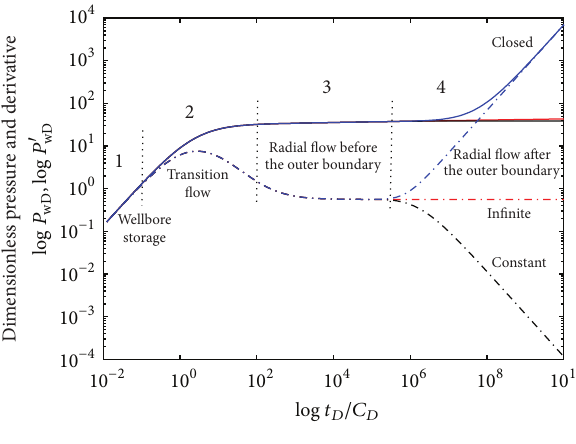
Figure 2: Thetypecurves of thefractal reservoirwith spherical